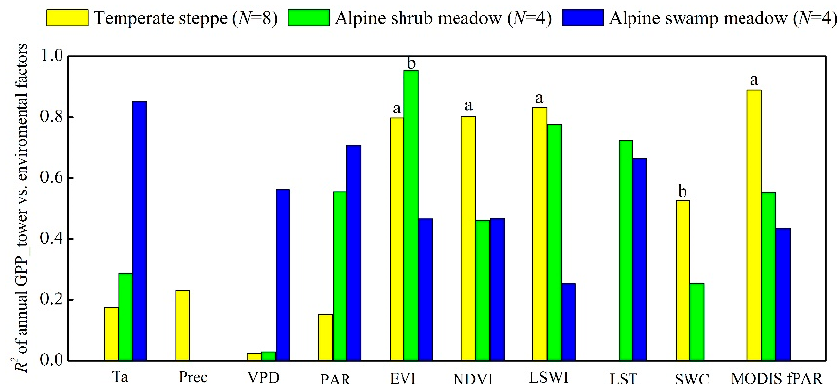
Figure 6. Correlations between the observed GPP (GPP_tower) and the climate variables or vegetation indices throughout the year. The observations at the two temperate steppe sites (NM and XL) were analyzed together since (1) they were observed in different years and (2) only two years of data were available for the NM site. a , significant at the 0.01 level; b , significant at the 0.05 level.